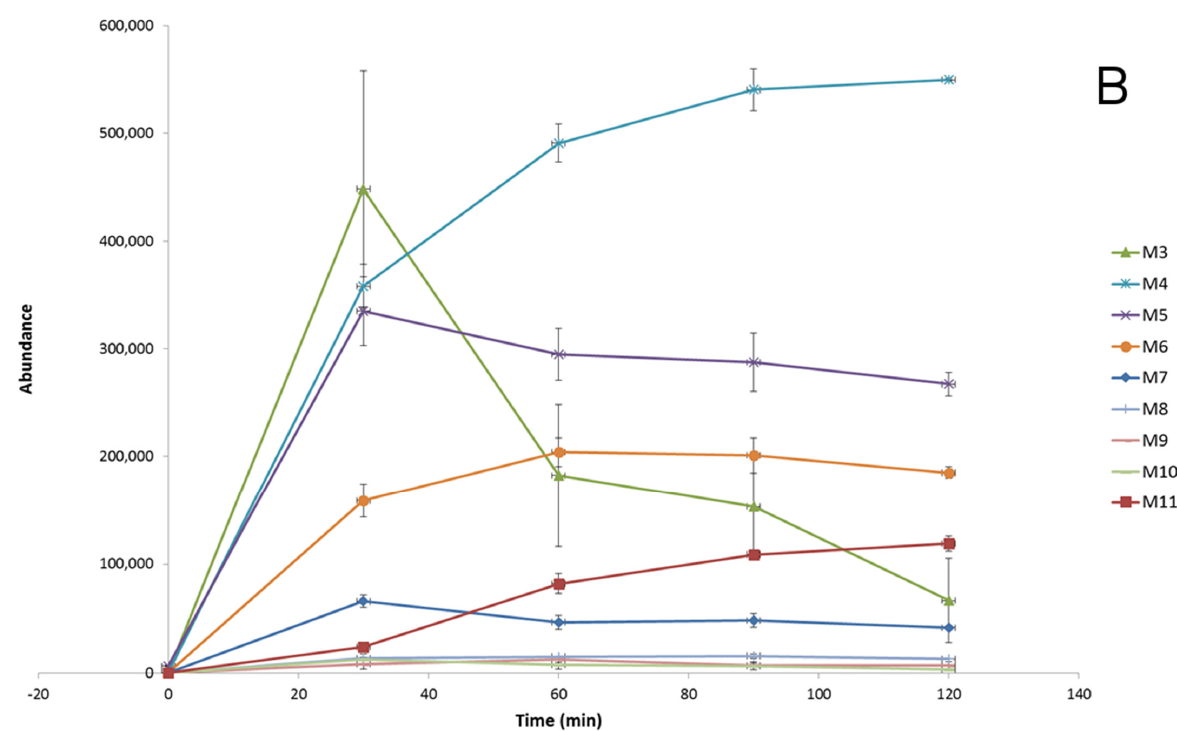
Figure 3. Evolution profiles of the dapoxetine metabolites ( A , B ) formed in HLM (presented as the function of time; error bars represent the standard deviation of the mean, n = 3).